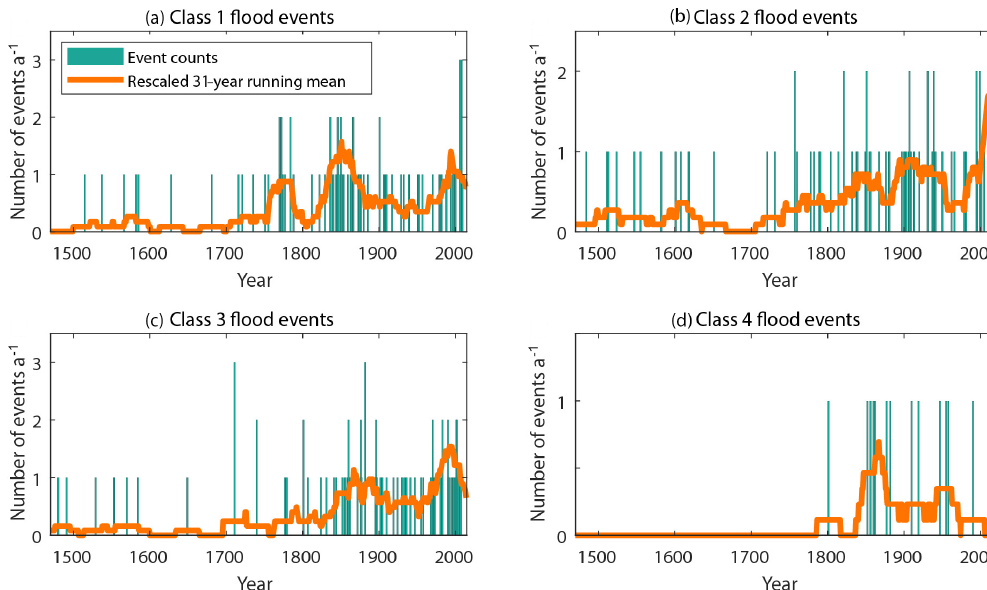
Figure 13. Chronologies according to the severity classes as defined in Tables